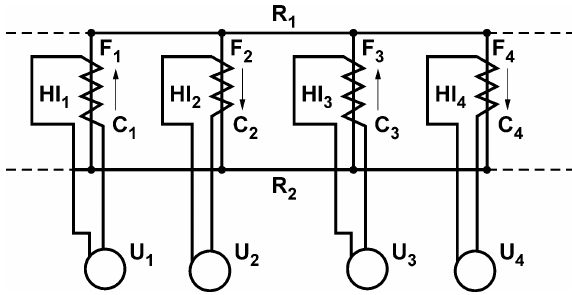
Figure 4. Diagram of an induction heating device circuit; R: rail, HI: inductor, C: coil, F: inductor core, and U: supply voltage [13].